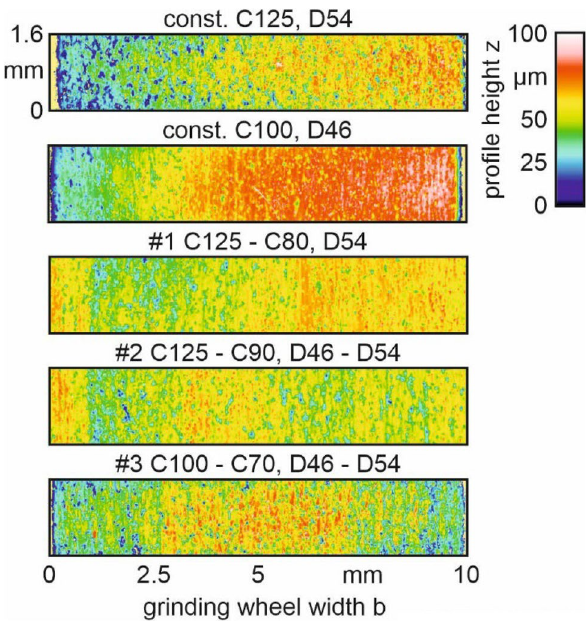
Fig. 9 Surface segments of the grinding wheels after operation